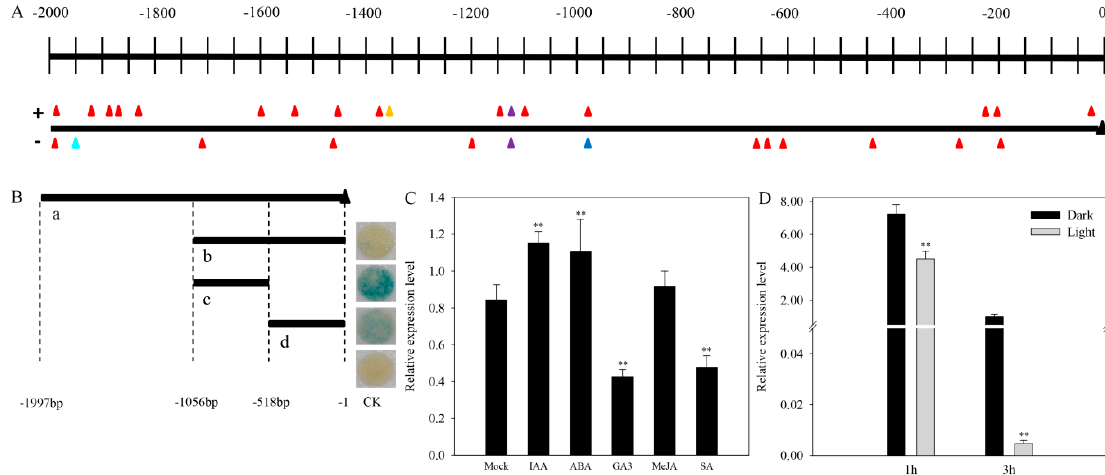
Figure 4. CaAMS promoter analysis and expression patterns of CaAMS in response to exogenous hormones and light. ( A ) Predicted cis -acting elements of the CaSEP5 promoter. Red represents light responsive elements; Blue indicates ABA responsive elements; Purple indicates MeJA responsive elements; Orange indicates SA responsive elements; Aqua indicates GA responsive elements. ( B ) Deletion analysis of the CaAMS promoter. Label a indicates the CaAMS promoter, labels b – d indicate four truncated promoter fragments and their corresponding GUS expression in tobacco leaf disks. ( C ) Expression patterns of CaAMS in response to exogenous hormones. ( D ) Expression patterns of CaAMS in response to light. ** indicates signi fi cant di ff erences at p < 0.01, respectively. ND means no di ff erence. Data are represented as means ± SD ( n = 3).